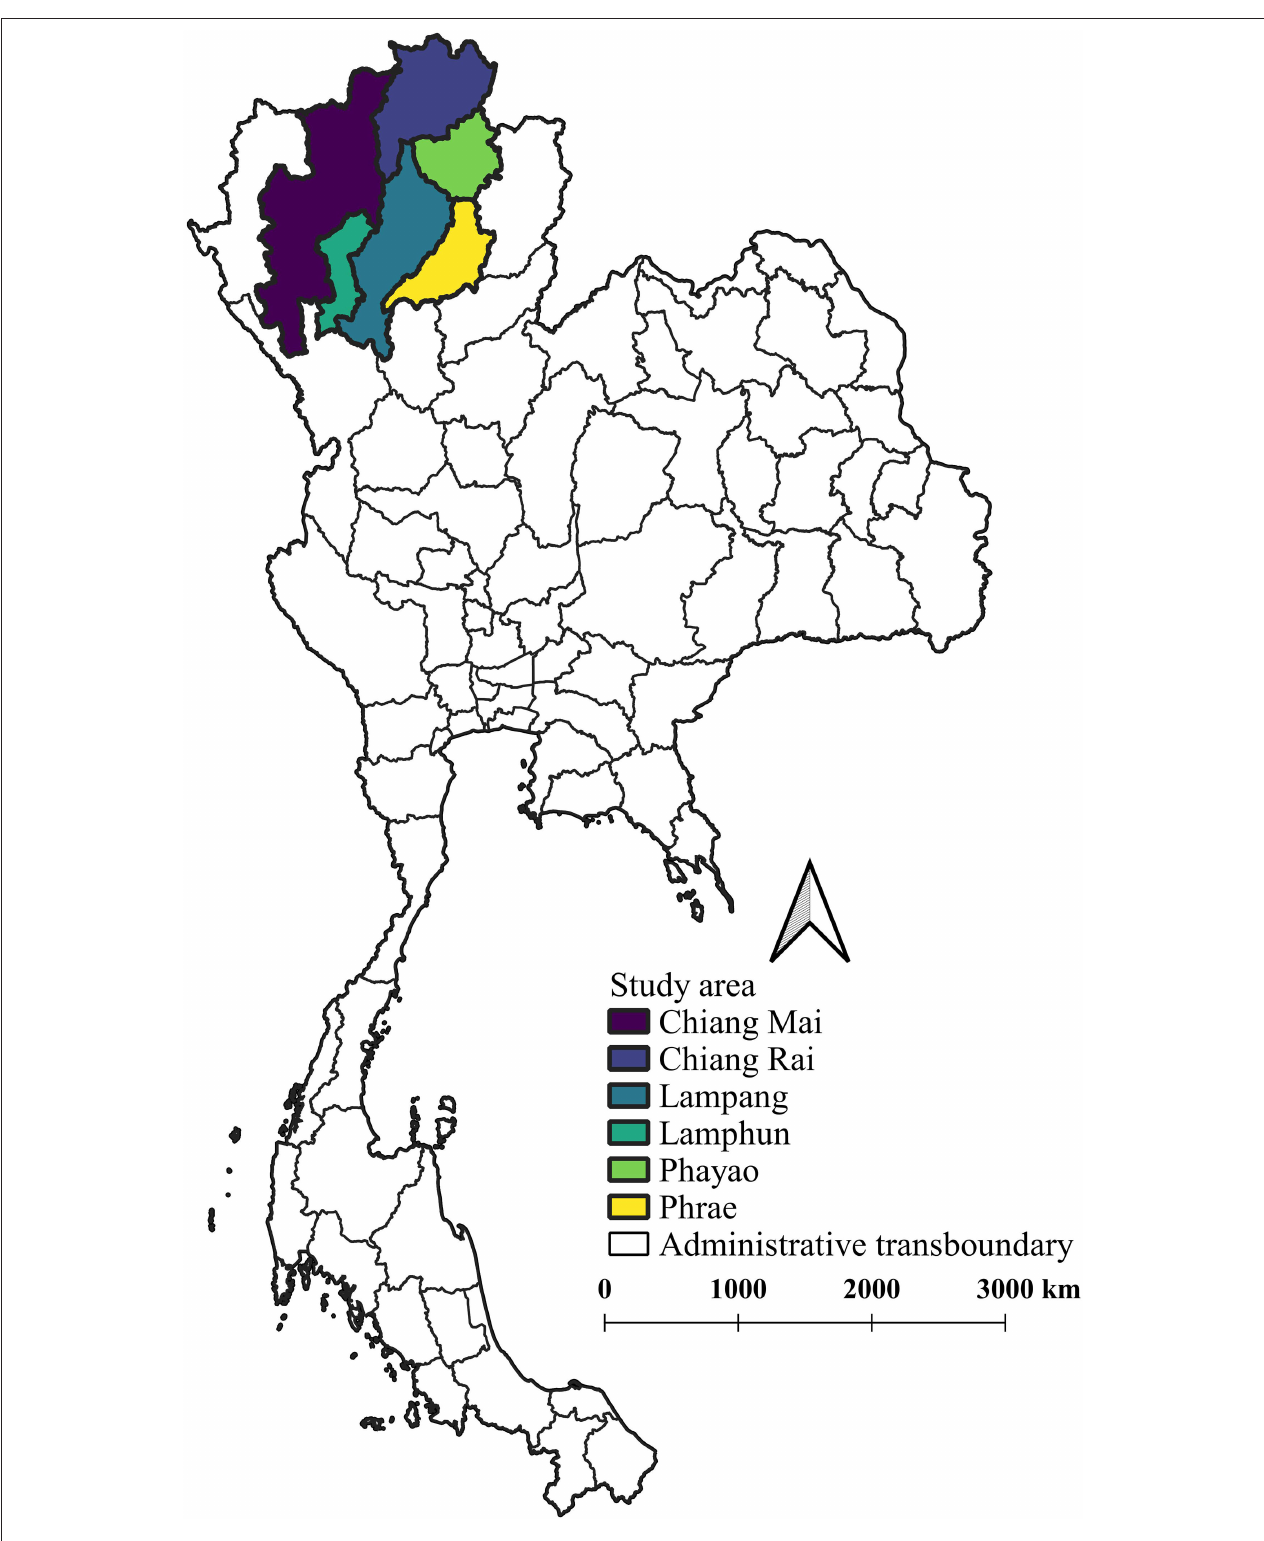
FIGURE 1 | A map of the provinces in northern Thailand where milk production data were collected. The map was created using QGIS (version 2.18.28), QGIS Geographic Information System, Open Source Geospatial Foundation Project, all content is licensed under Creative Commons Attribution ShareAlike 3.0 license (CC BY-SA), available at